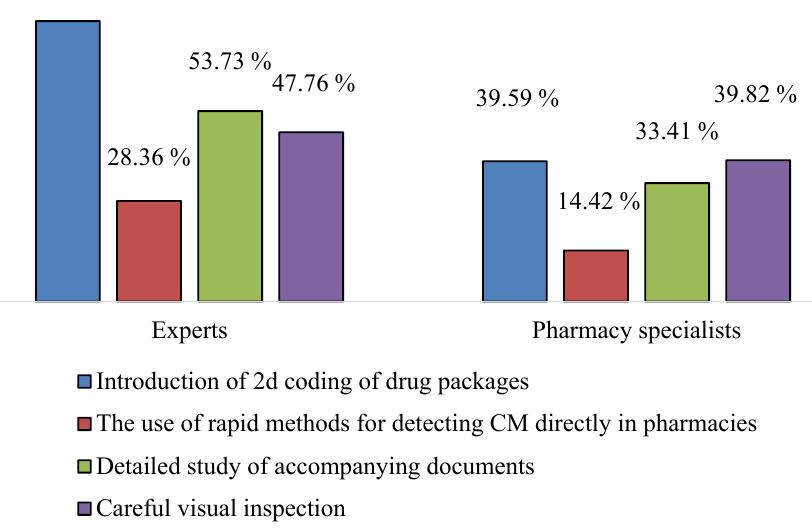
Fig. 4. The results of the survey on the main methods that allow to detect counterfeit